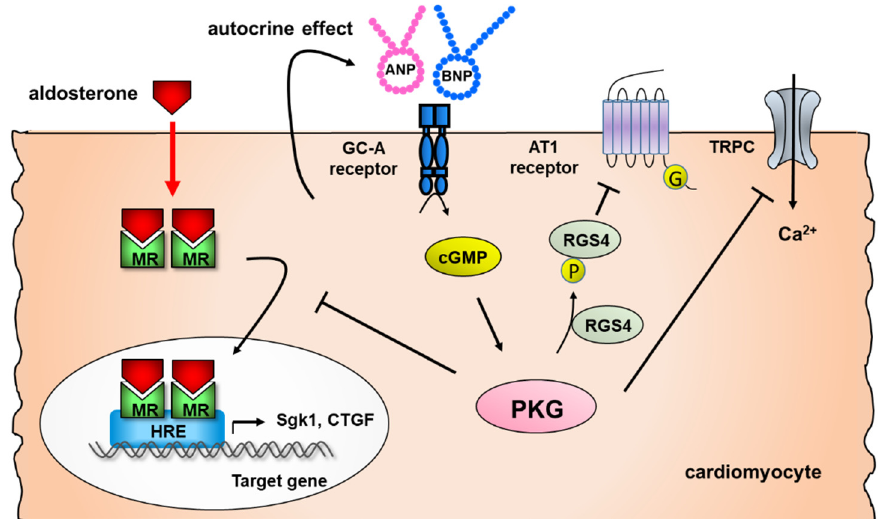
Figure 1. Protective autocrine effects of natriuretic peptides against adverse cardiac remodeling in cardiomyocytes. Natriuretic peptides/GC-A signaling phosphorylates regulator of G-protein signaling subtype 4 (RGS4), resulting in the inhibition of G α q signaling coupled with Ang II type 1A receptor [33,34], inhibits the activation of transient receptor potential C6 (TRPC6) [35] and attenu- ates the genomic actions of the cardiac mineralocorticoid receptor (MR) in cardiomyocytes [37].